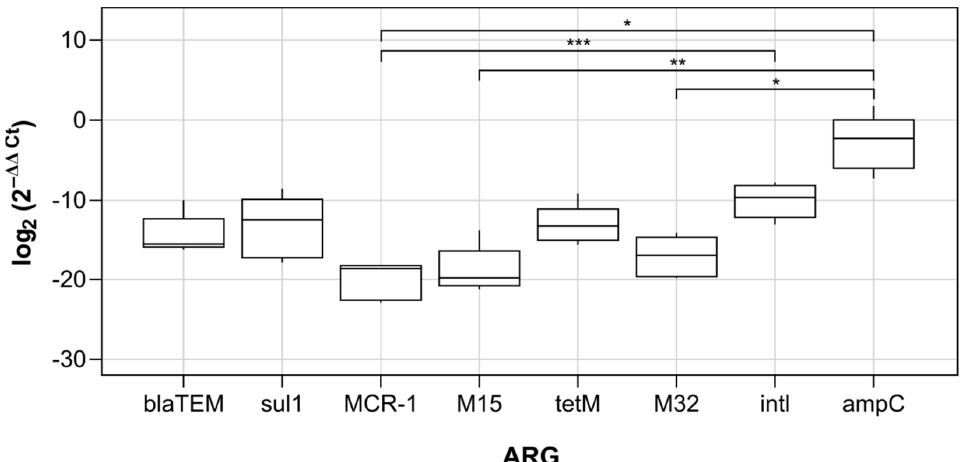
Figure 3. Relative abundance obtained from qPCR Ct values (normalized ARGs copies to 16s rRNA copies) of the seven ARGs analyzed in bacteria from the influent and effluent of Brno-Mod ř ice WWTP. Box plots represent the median (horizontal line in the box), the lower and upper quartiles (bottom and top box lines), and the lower and upper 1.5 IQR (bottom and top whiskers). The statis- tical difference between the influent and effluent was tested by Mann-Whitney test and the signifi- cance is marked with * for p < .05, ** for p < .01